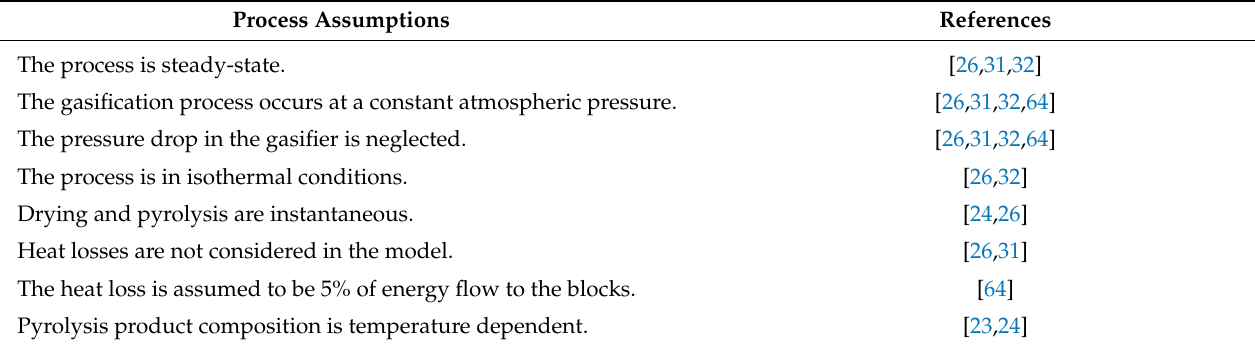
Figure 6. Predicted producer gas composition and LHV ( a ), and relative errors of simulation models ( b ) for the steam gasification of woody biomass in a dual fluidised-bed gasifier. The model IDs are given in Table 6. Table 7. Assumptions made in the Aspen Plus simulation of biomass steam